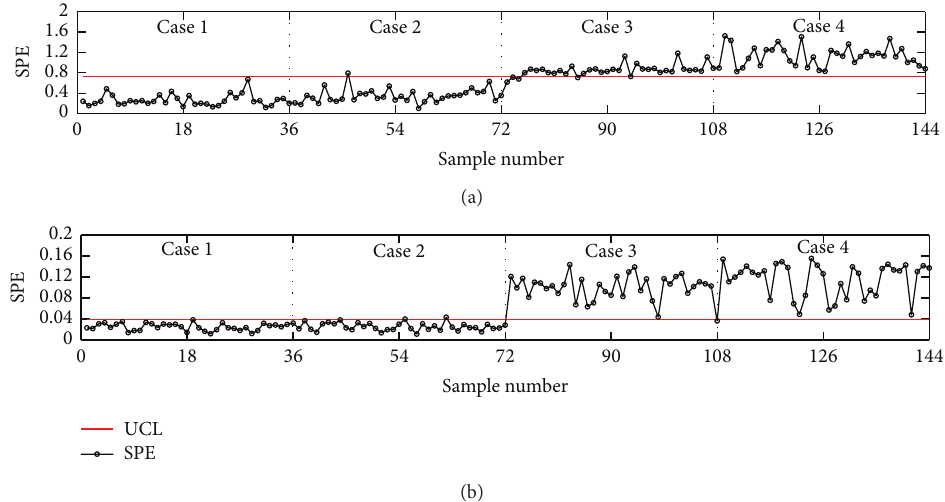
Figure 6: Monitoring charts of KPCA-based method using (a) natural frequencies and (b) COMAC.